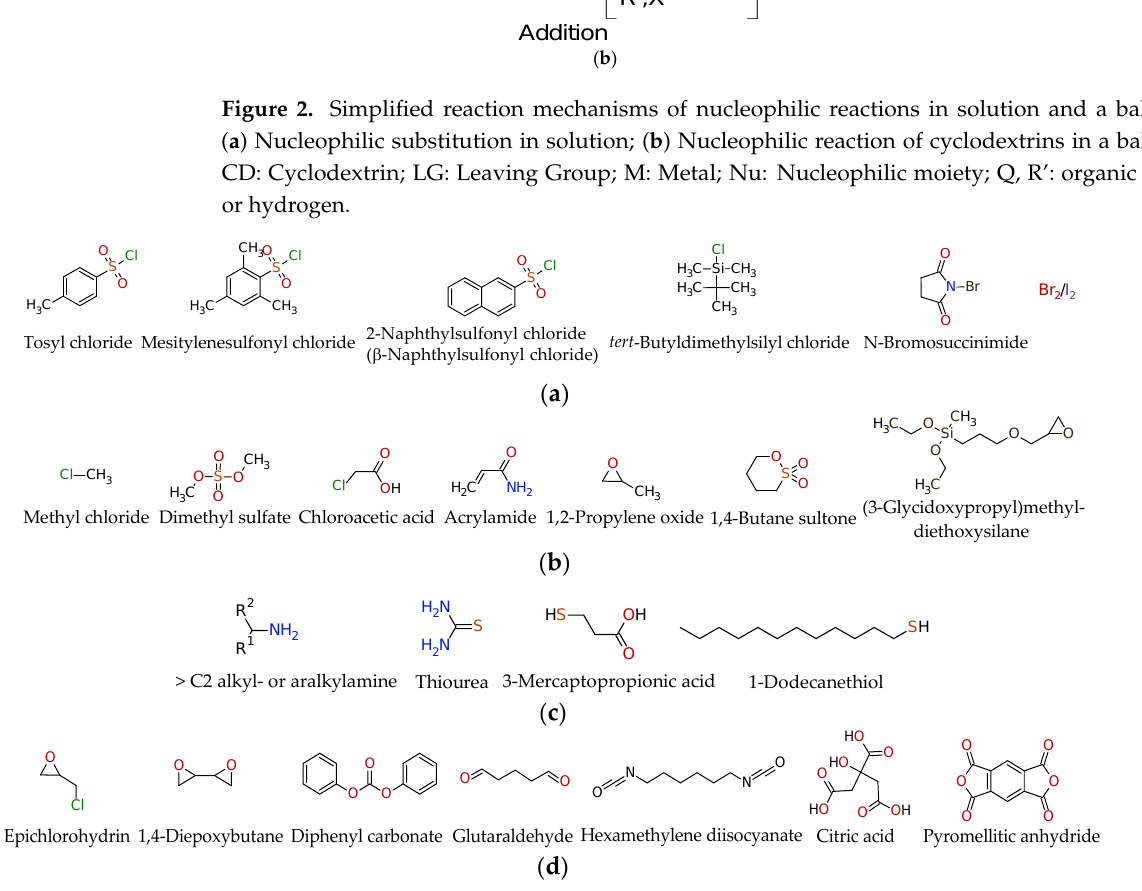
Figure 2. Simplified reaction mechanisms of nucleophilic reactions in solution and a ball mill. ( a ) Nucleophilic substitution in solution; ( b ) Nucleophilic reaction of cyclodextrins in a ball mill; CD: Cyclodextrin; LG: Leaving Group; M: Metal; Nu: Nucleophilic moiety; Q, R’: organic group or hy- drogen.